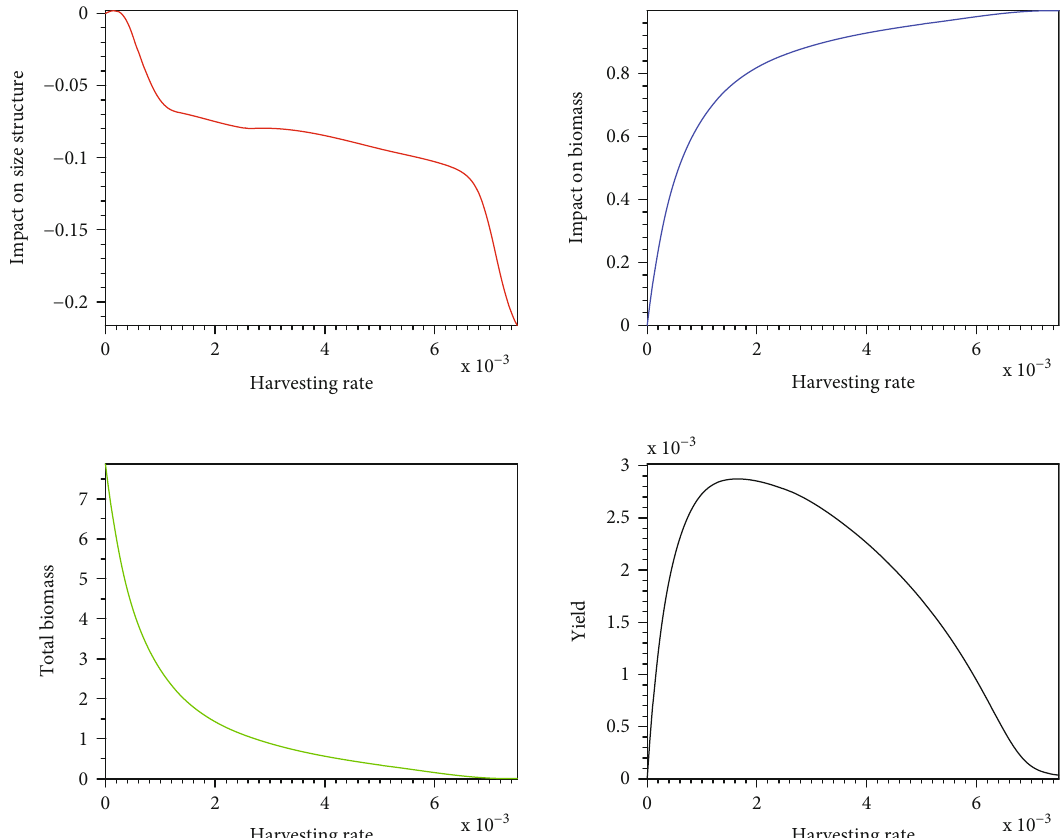
Figure 4: Simulation results, using system (18), including both African cat fi sh and Nile tilapia. The fi gures show the dependence of impact on size structure (red curve), impact on biomass (blue curve), total biomass (green curve), and yield (black curve) with respect to equal ! harvesting rates, i.e., h = ð h , h , h , h , h , h Þ . The initial values are chosen positive, and other parameter values can be found in Tables 3 –